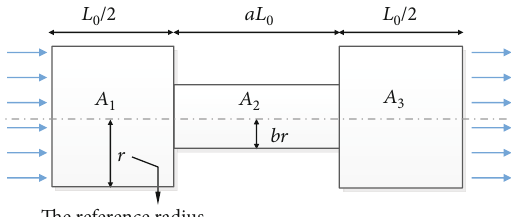
Figure 10: Pore model for calculating local energy loss.